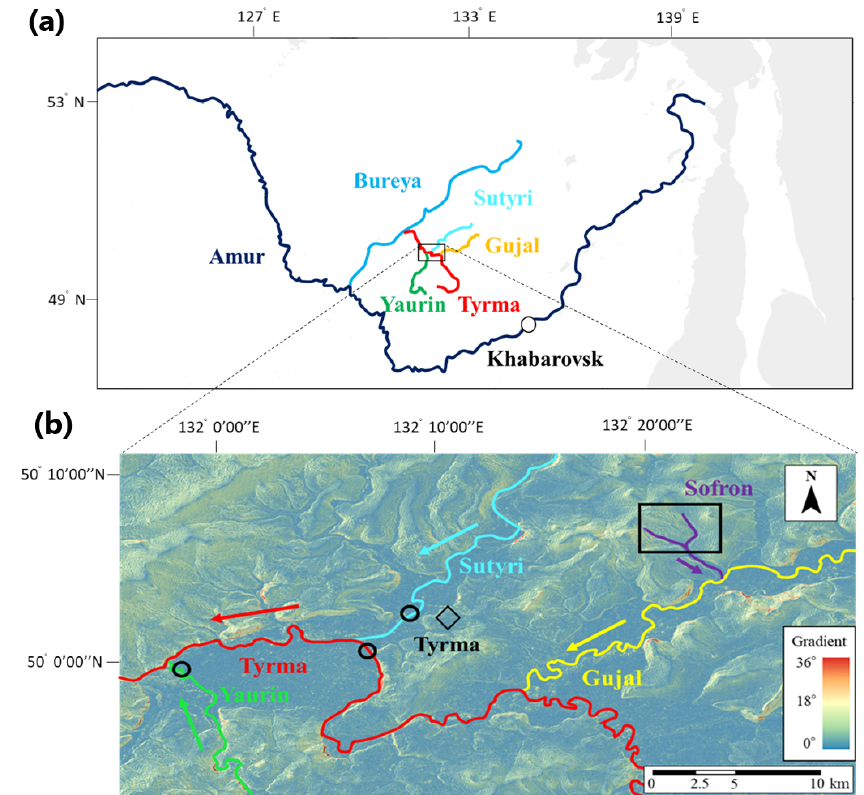
Figure 1. ( a ) map of the Amur River basin; ( b ) map of the Tyrma region with the large rivers where water samples were collected. This map is colored by a gradient (degree) to clearly show terrain characteristics. As for the symbols in map ( b ), the black rectangle denotes the Sofron River watershed where intensive research was conducted; black circles denote the river water sampling sites of the Sturi, Tyrma, and Yaurin Rivers; and black diamond denotes the Tyrma village. This map was created by the authors based on 30 m resolution digital elevation model (DEM) provided by the Japan Aerospace Exploration Agency